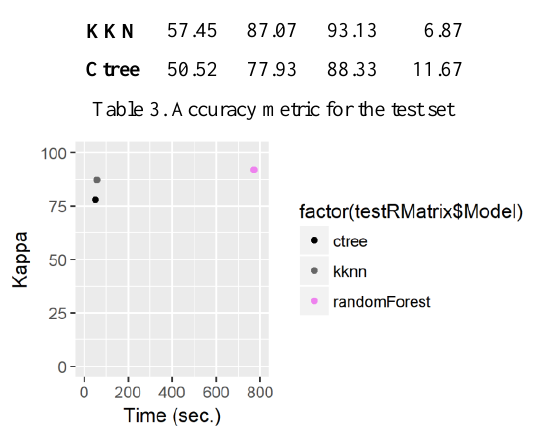
Figure 4, Time vs K accuracy for the test